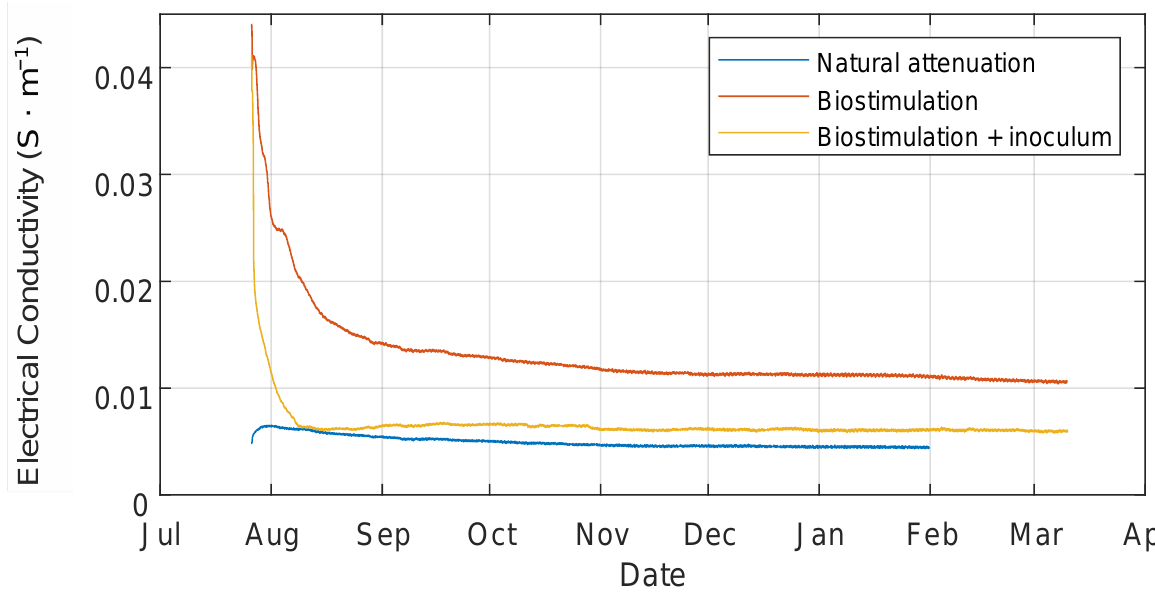
Figure 3. Electrical conductivity of the tested mesocosms corrected for temperature. The trend of electrical permittivity, which the probe measures separately from the electrical conductivity, pointed out other interesting behaviour (Figure 4).